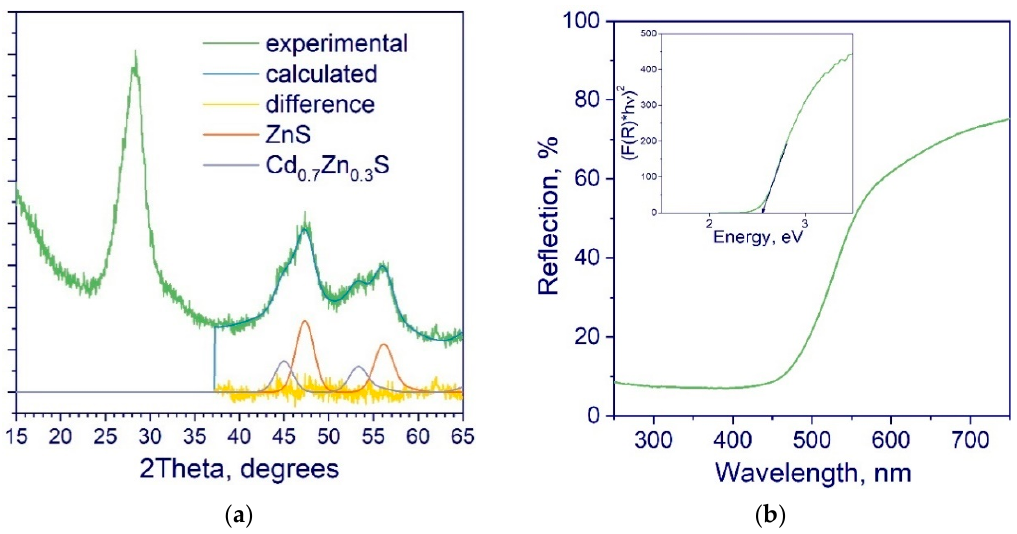
Figure 1. X-ray diffraction (XRD) pattern with the deconvolution of the two last peaks ( a ) and diffuse reflectance spectrum with the Tauc plot ( b ) of the synthesized sample.